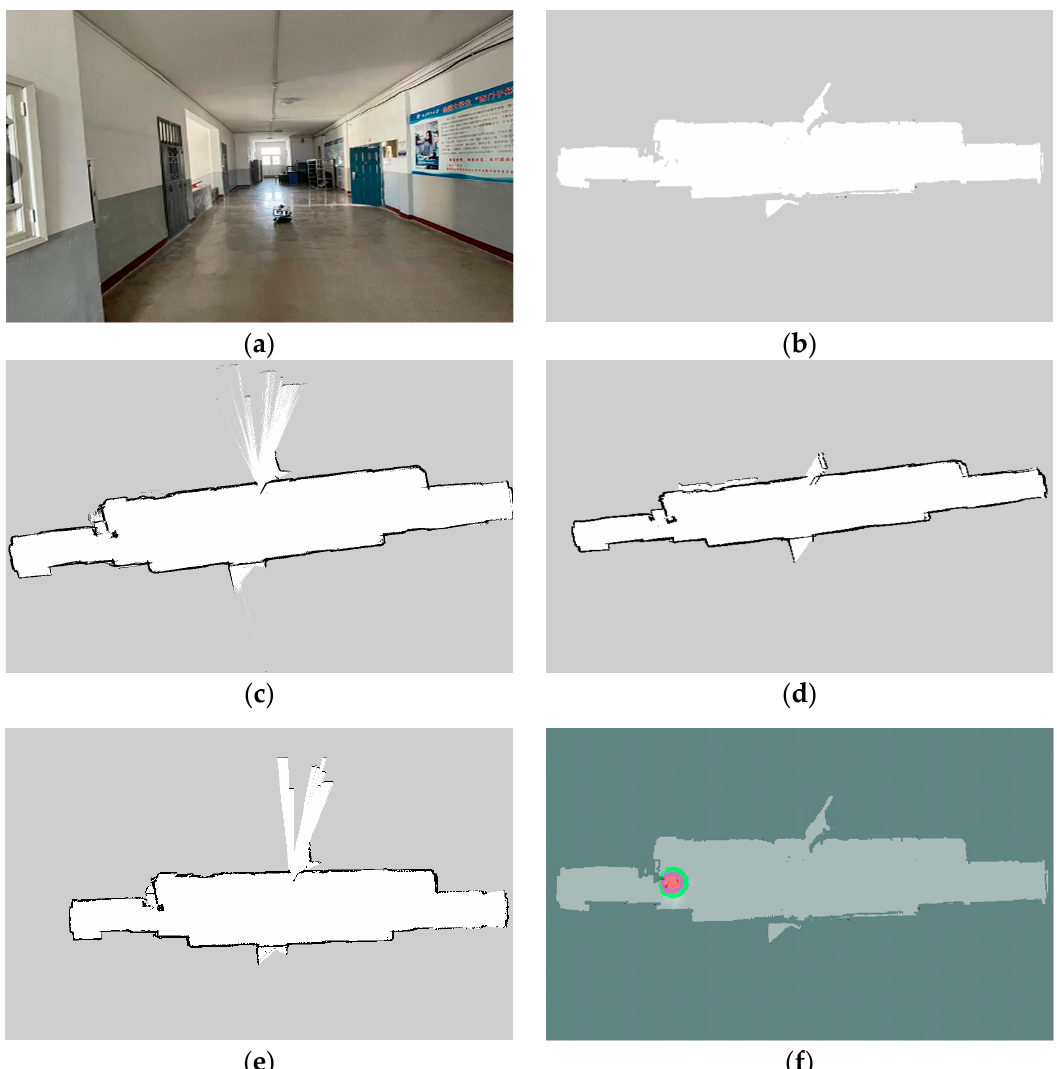
Figure 13. The result of the indoor scene map building: ( a ) the real environment, ( b ) the mapping result of Cartographer, ( c ) the mapping result of Gmapping, ( d ) the mapping result of Hector_SLAM, ( e ) the mapping result of the Karto_SLAM algorithm, and ( f ) the radiation mapping result of the indoor environment with one radiation source.